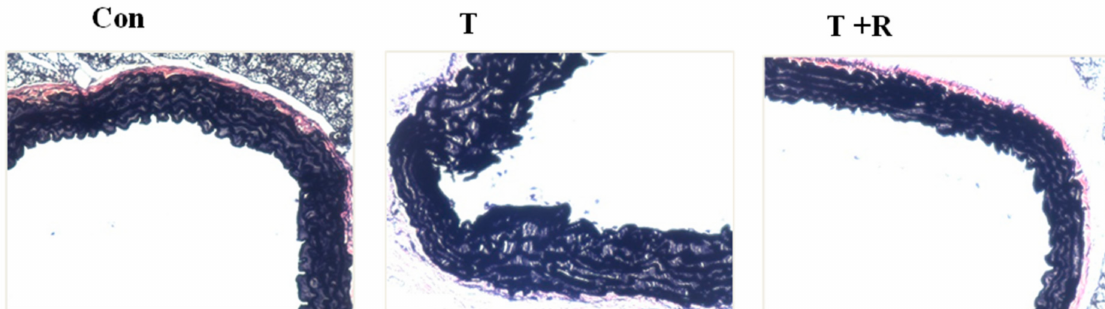
Figure 6. Representative aortic elastin fibers were visualized using Verhoeff–Van Gieson staining (magnification of 40 × , scale bar = 50 µ m). C57BL/6 mice were fed AIN-93G rodent diets with and without 0.4% resveratrol for one week followed by 25 µ g/kg/day of TNF- α injected intraperitoneally for 7 days. After the treatment periods, the animals’ aortas were harvested for sectioning. T, TNF- α ; R, resveratrol; T + R, TNF- α + resveratrol.